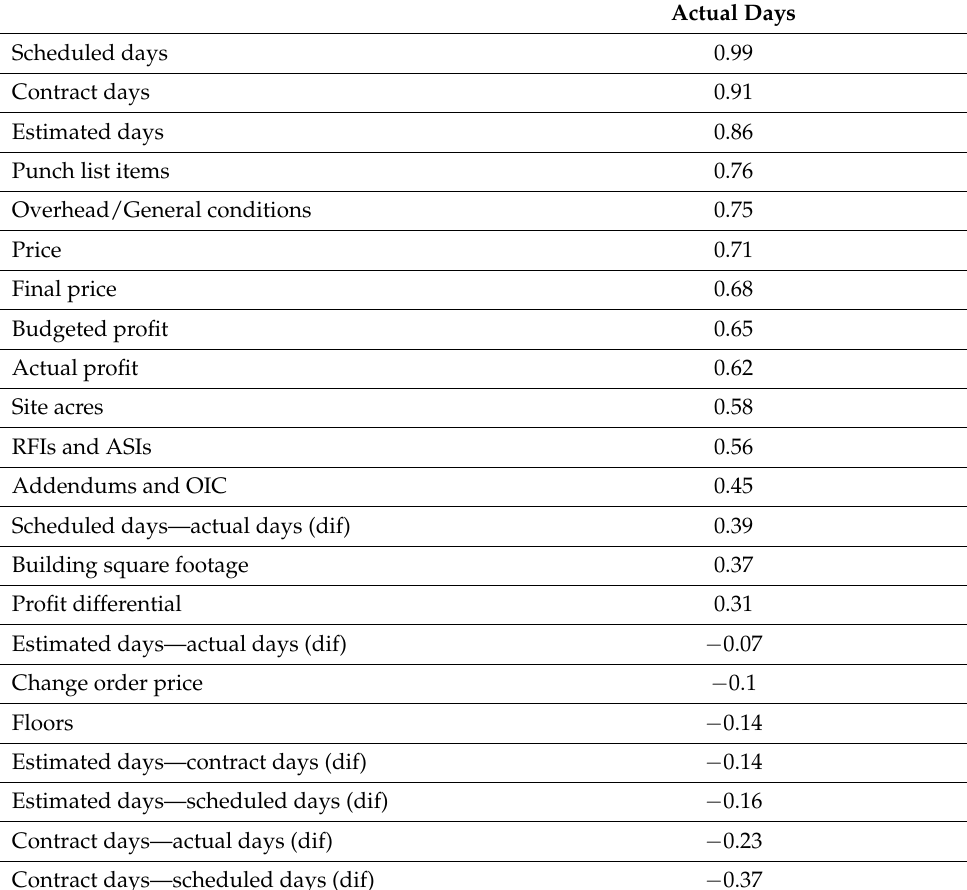
Table 6. Correlations for actual construction